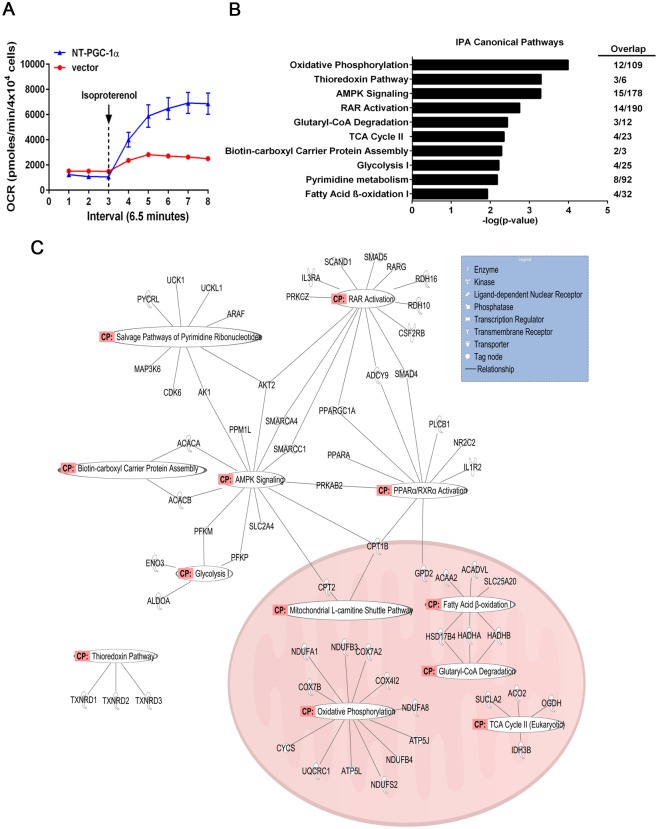
Pathway analysis of NT-PGC-1α-responsive genes in brown adipocytes.(A) Oxygen consumption rates of brown adipocytes expressing NT-PGC-1α or empty vector. Basal and isoproterenol-stimulated mitochondrial respiration (n = 5) was measured as described in Materials and Methods. (B) Ingenuity pathway analysis on the genes whose expression was elevated by NT-PGC-1α compared to controls in brown adipocytes. The statistically significant canonical pathways identified are listed according to their –log (p-value). The number of overlapping genes detected in each pathway was shown. (C) Functional interaction analysis of 65 genes that are enriched in the metabolic and signal transduction pathways identified by the IPA analysis. Genes or gene products are displayed as nodes that represent the functional class of the gene product, and a biological relationship between two genes is represented as a line.